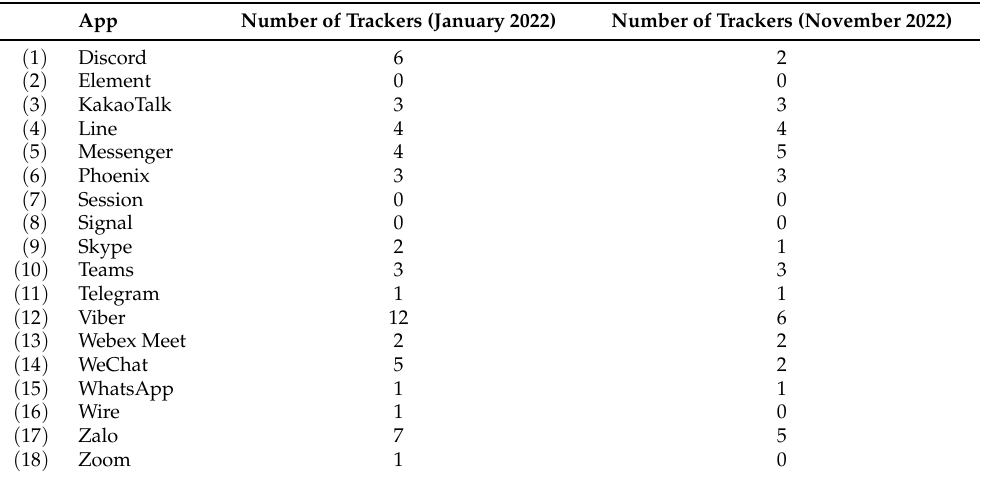
Table 2. Number of trackers embedded into video conferencing